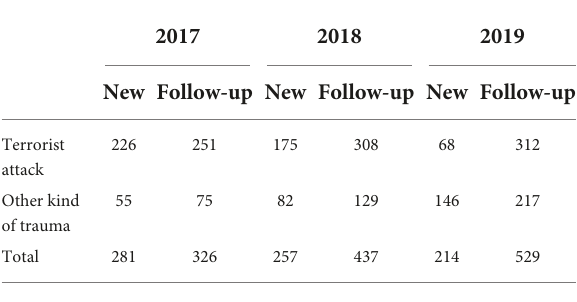
TABLE 1 NPPC consultations per